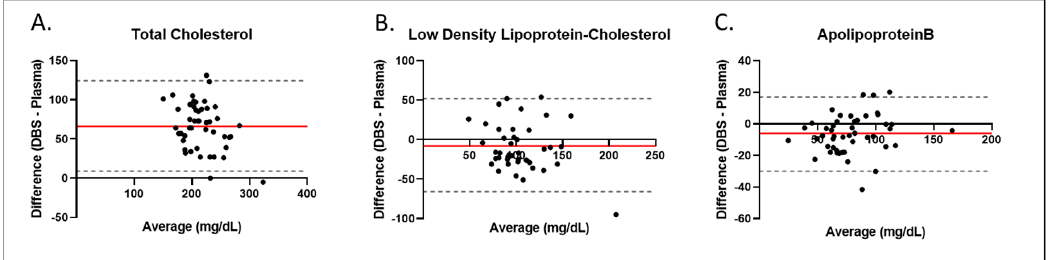
Figure 2. Comparison of Serum to DBS Assays. The Bland–Altman plots show the variation in the serum as compared to the DBS concentration for specimens collected concurrently in 48 research subjects. ( A ) Total cholesterol; ( B ) low-density lipoprotein-cholesterol; ( C ) apolipoprotein B. Red line, bias; dashed Line, 95% limits of agreement.